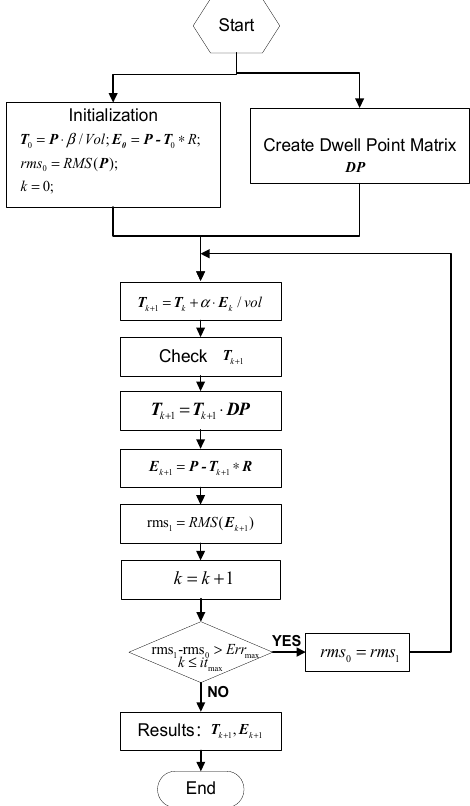
Figure 5. Flow chart of the dwell time algorithm.